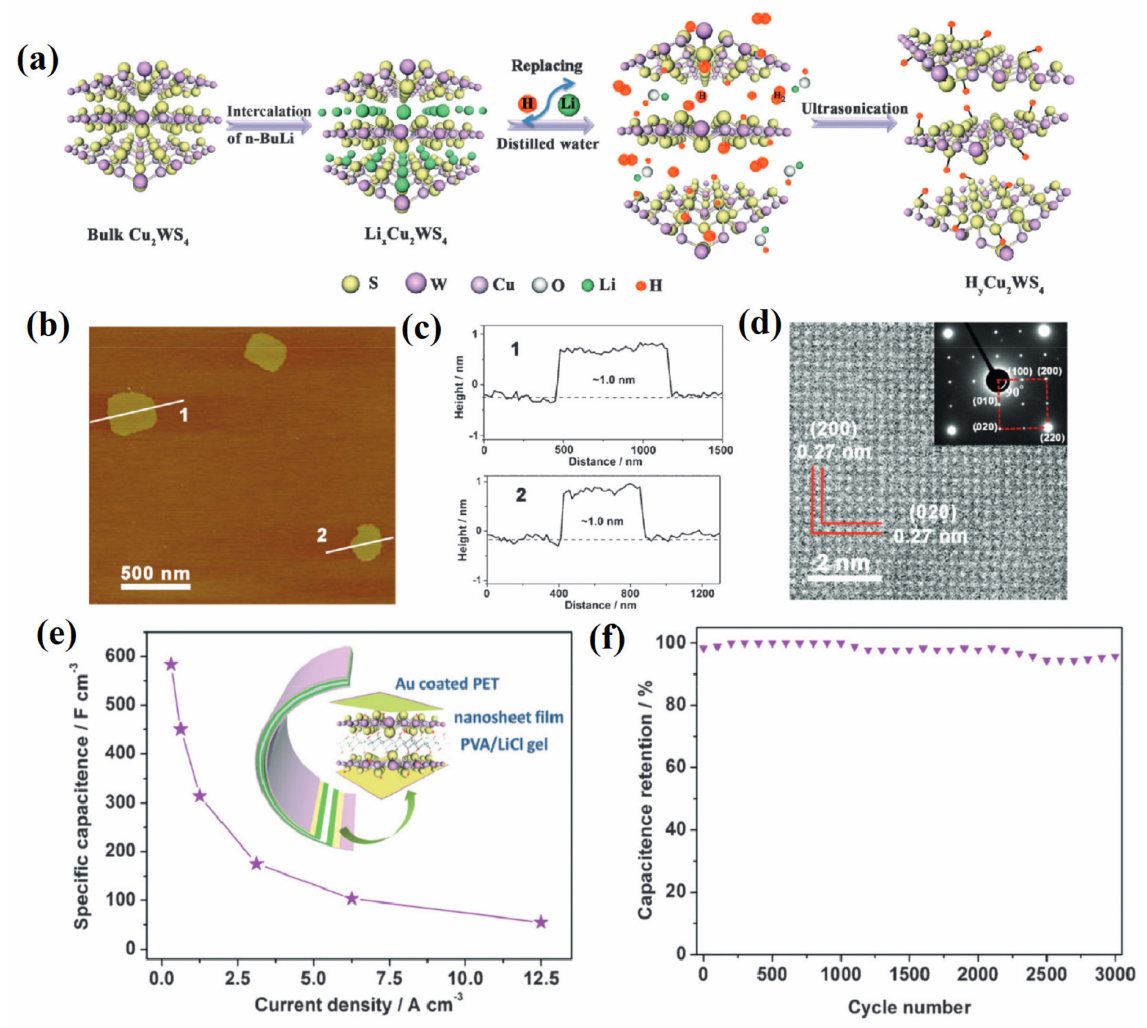
Figure 22. ( a ) Formation of nanosheets of hydrogenated-Cu 2 WS 4 . ( b ) AFM image, ( c ) Corresponding height diagram, ( d ) HRTEM image, and SAED pattern of the as-synthesized nanosheets. ( e ) Specific capacitance vs. current density (inset: schematic illustration of the as-fabricated symmetrical SC). ( f ) Cycling performance at 1.25 A/cm 3 . Adapted with permission [369]. Copyright (2016) John Wiley and